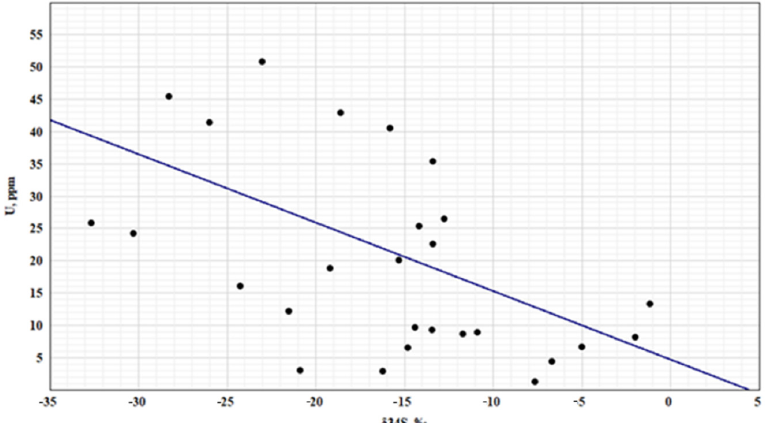
Figure 6. Cross ‐ plot of uranium concentration and sulfur isotopic composition for well 1, Bazhenov